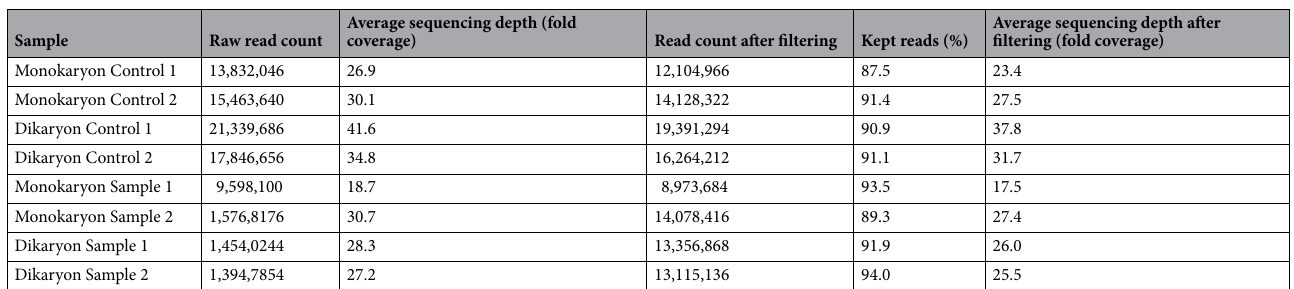
Table 1. Sequencing read counts for the samples in this study. Masked reads are after filtering on paired-end aligned reads that are unique and not identified as optical duplicates.